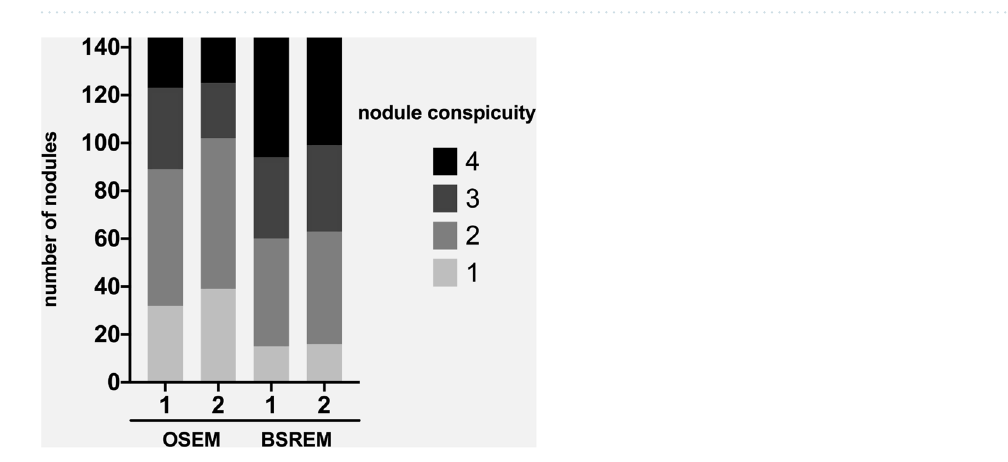
Figure 3. Subjective image quality ratings of reader 1 and reader 2 for ordered subset expectation maximization (OSEM) and block sequential regularized expectation maximization (BSREM) reconstruction